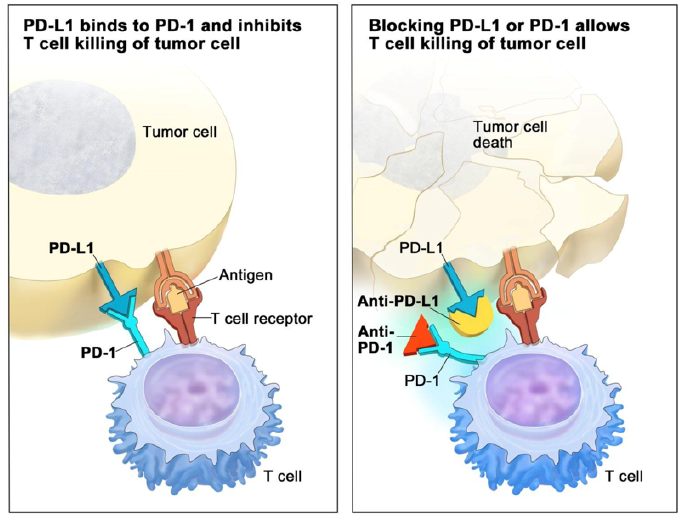
Figure 1. Scheme how checkpoint blockers work. PD-L1 and PD-1 pathway ( left ) and inhibitors are shown ( right ).